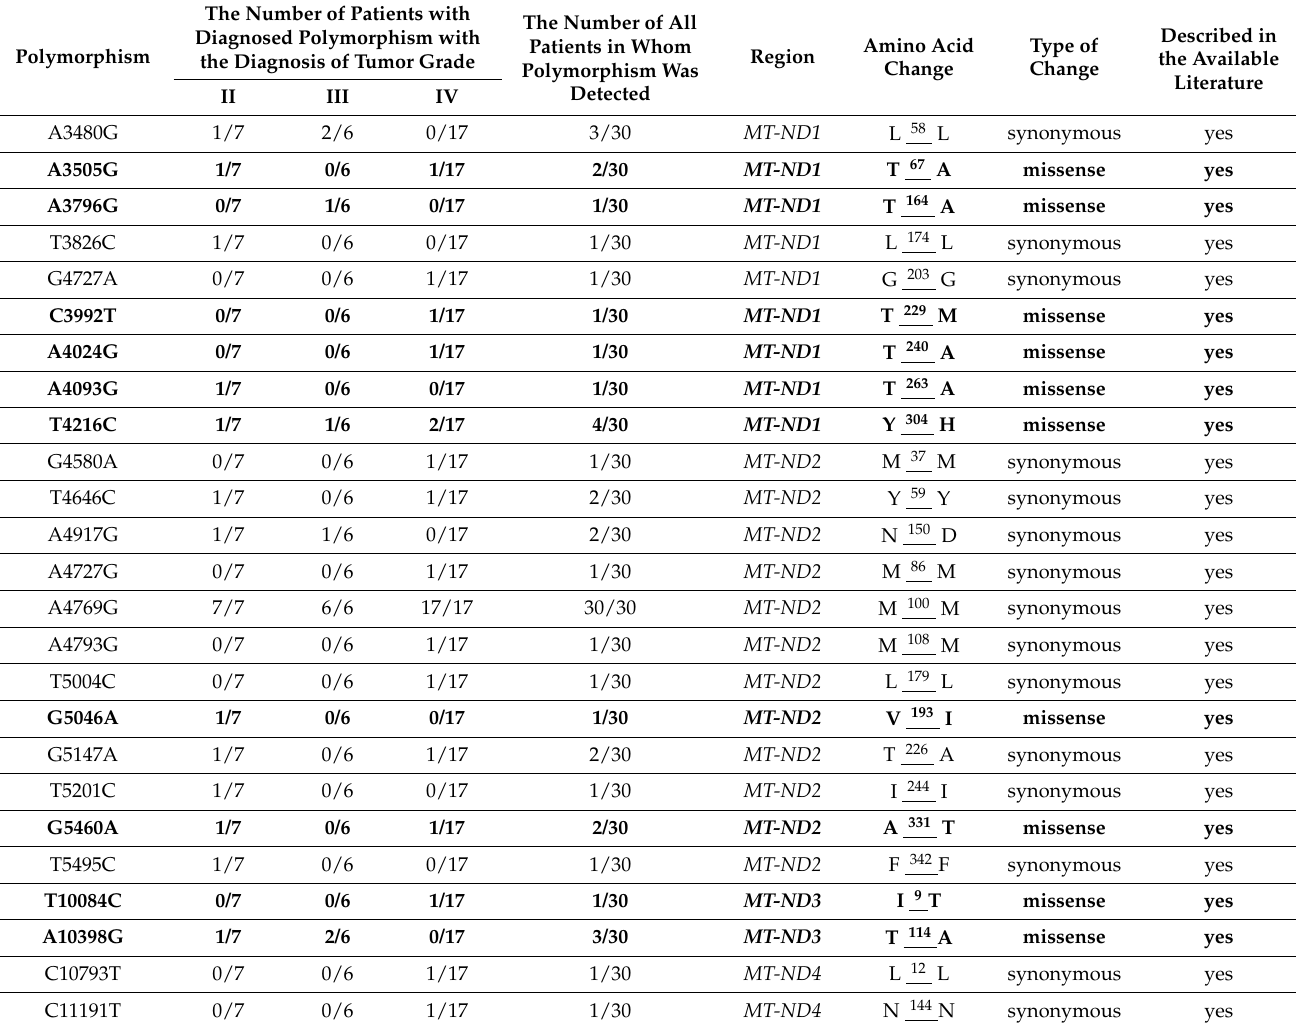
Table 2. Summary of all detected polymorphisms and mutations in genes of the mitochondrial complex